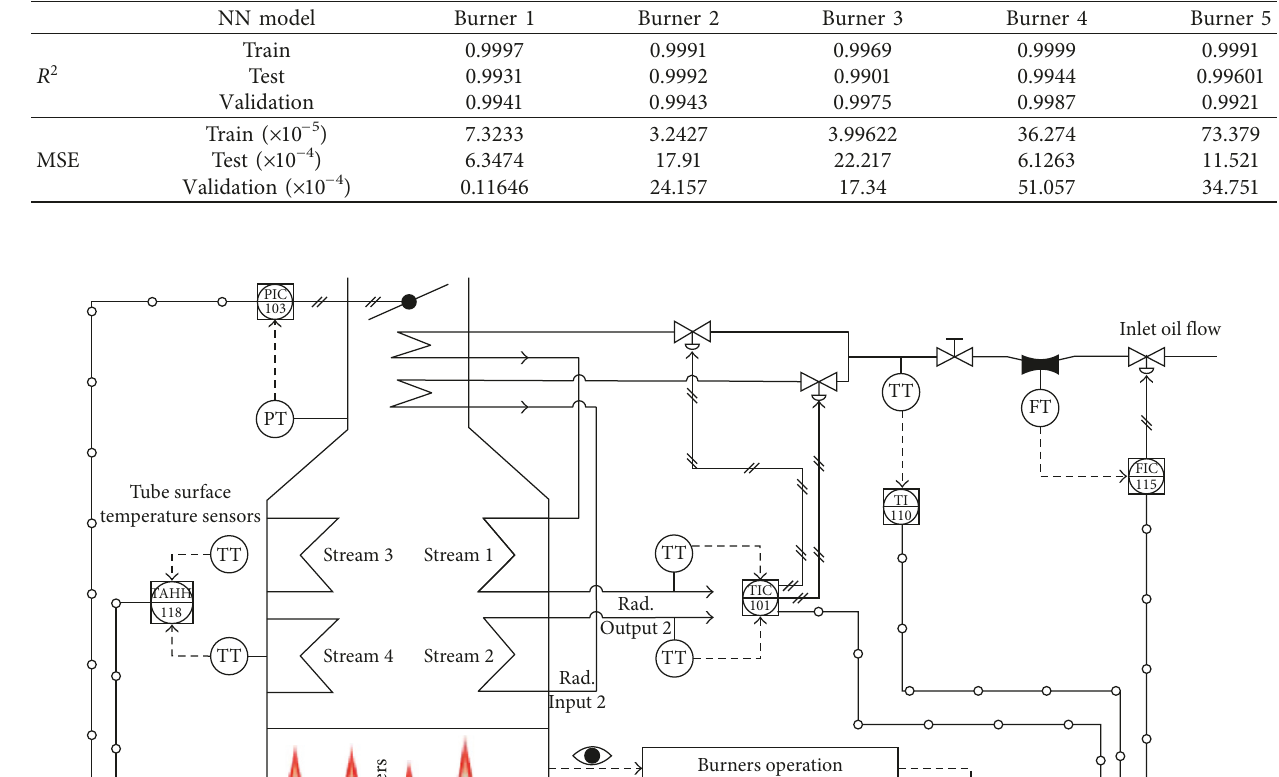
Table 6: The performances of the developed neural network estimator.